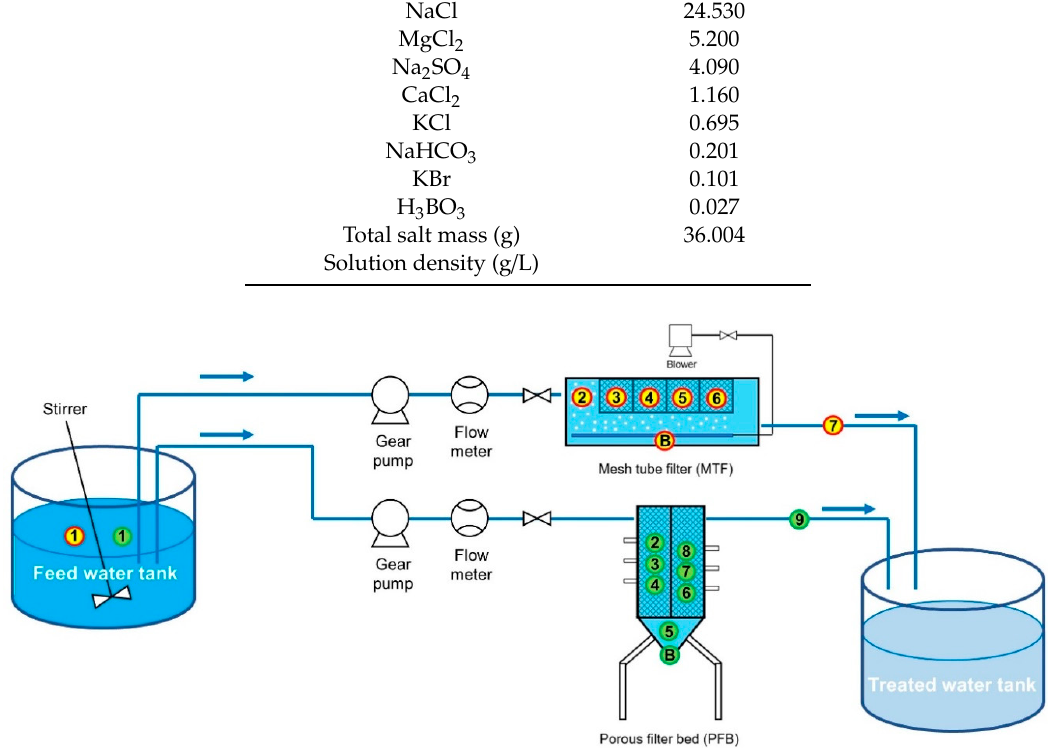
Figure 3. Schematic diagram of the experimental set-up. (The numbers in the figure refer to the sampling points, the numbers in the red circle indicate the MTF sampling points, and the numbers in the green circle indicate the PFB sampling points.).